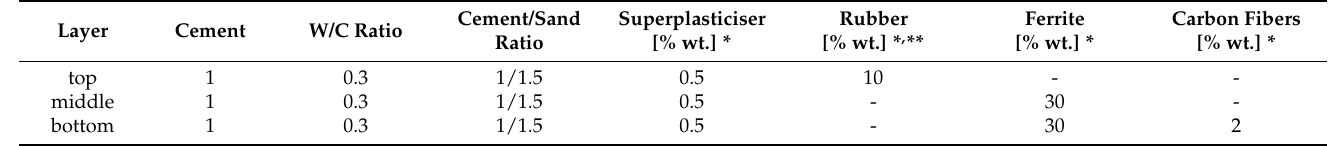
Table 3. Composition of the particular absorber layers (after